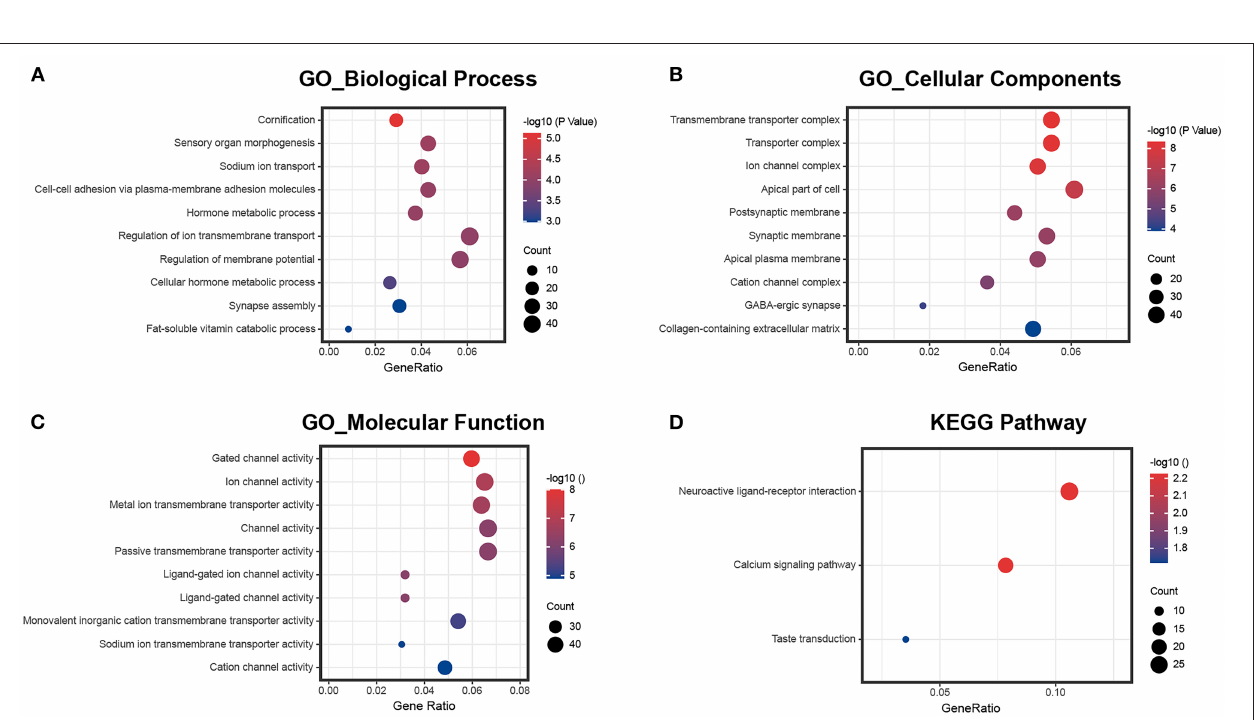
FIGURE 2 | GO and KEGG pathway enrichment of differentially expressed mRNAs. (A) The ten most enriched biological process GO terms; (B) the ten most enriched cellular component GO terms; (C) the ten most enriched molecular function GO terms; (D) KEGG pathway enrichment analysis.